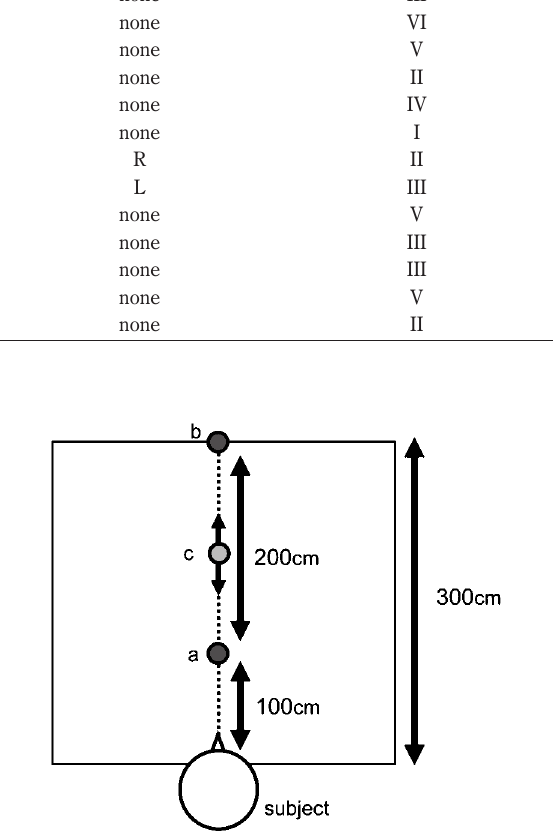
Figure 1 Experimental setting for the depth perception test: Antero- posterior direction. Subjects were asked to indicate the position of marker c (open circle) at the midpoint between markers a and b (gray